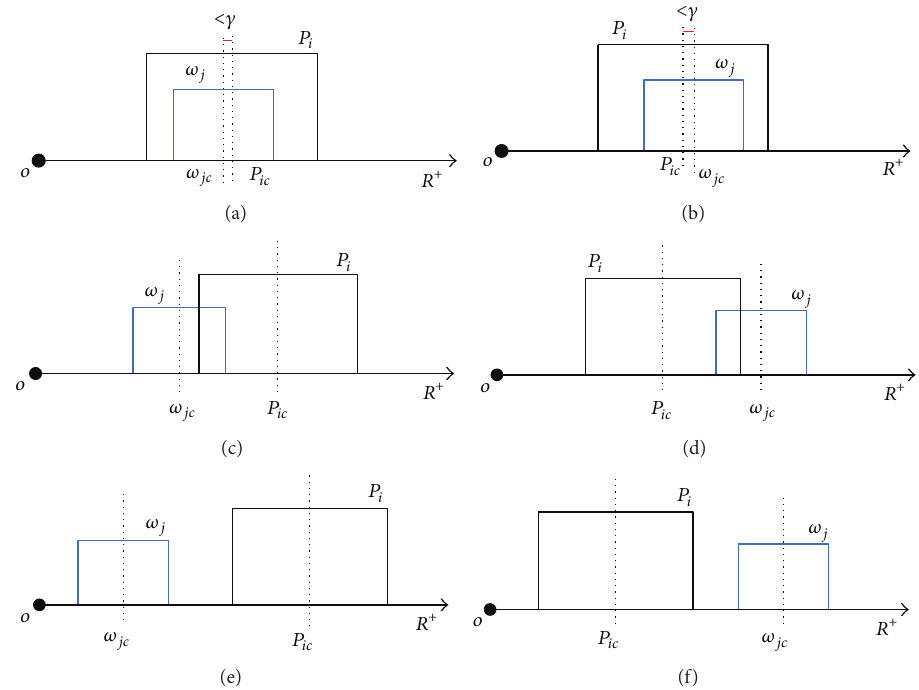
Figure 3: Relationships between 𝑃 𝑖 and 𝜔 𝑗 . (a) 0 ≤ 𝑃 𝑖𝑐 − 𝜔 𝑗𝑐 ≤ 𝛾 , overlapping. (b) −𝛾 ≤ 𝑃 𝑖𝑐 − 𝜔 𝑗𝑐 ≤ 0 , overlapping. (c) 𝑃 𝑖𝑐 > 𝜔 𝑗𝑐 , overlapping. (d) 𝑃 𝑖𝑐 < 𝜔 𝑗𝑐 , overlapping. (e) 𝑃 𝑖𝑐 > 𝜔 𝑗𝑐 , not overlapping. (f) 𝑃 𝑖𝑐 < 𝜔 𝑗𝑐 , not